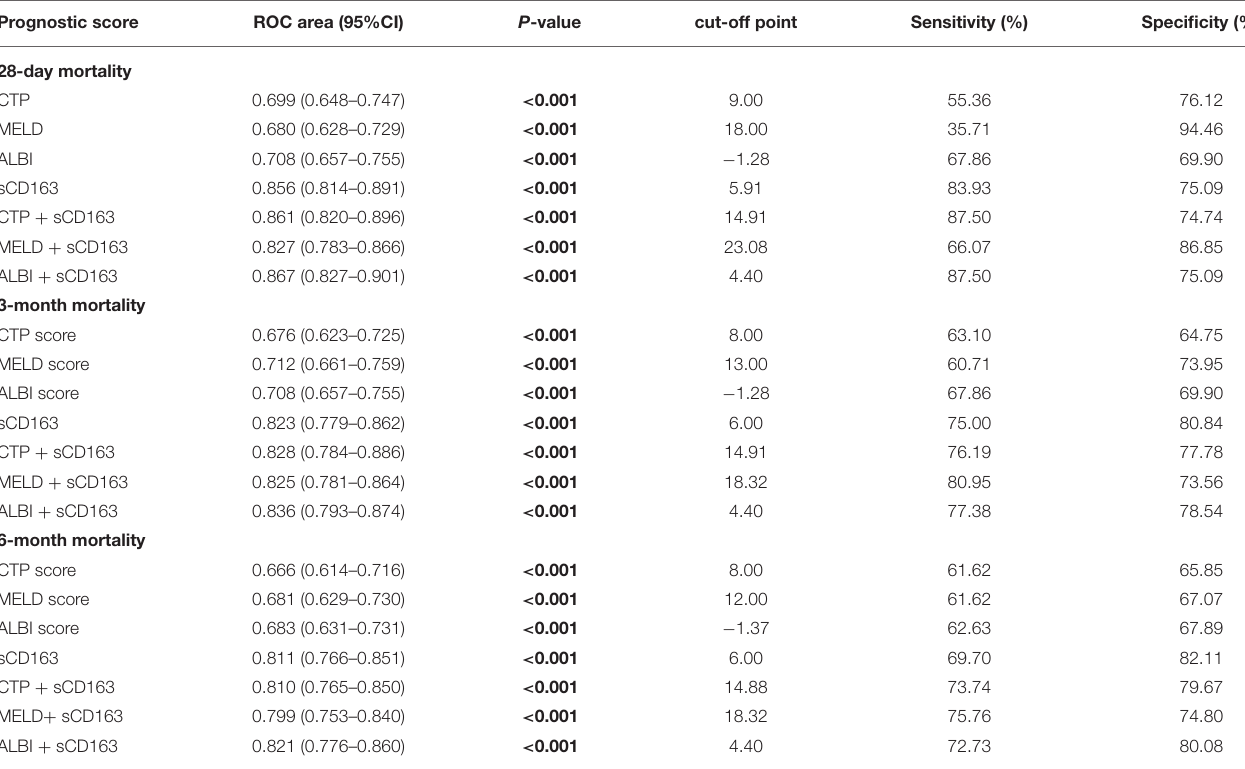
TABLE 5 | The performance of sCD163 and the prognostic scores for predicting outcome at 28 days, 3 months and 6 months. Prognostic score